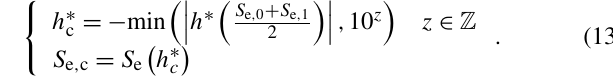
Figure 1. Concept of the mixed formulation, S M (h 0 ,h 1 ) : the integration of sum of the integration of two bounded functions over bounded intervals, data are depicted on a log scale for clarity, but the integration is performed directly on the integrands instead of their log-scaled counterparts. Consequently, the integrals do not correspond to the areas below the curves, conversely to the case of linear scales. An illustrative case of the computation of sorptivity, S M (h 0 ,h 1 ) , for a synthetic loamy soil with an initial water pressure head of − 10 3 mm and a final water pressure head of − 10 − 1